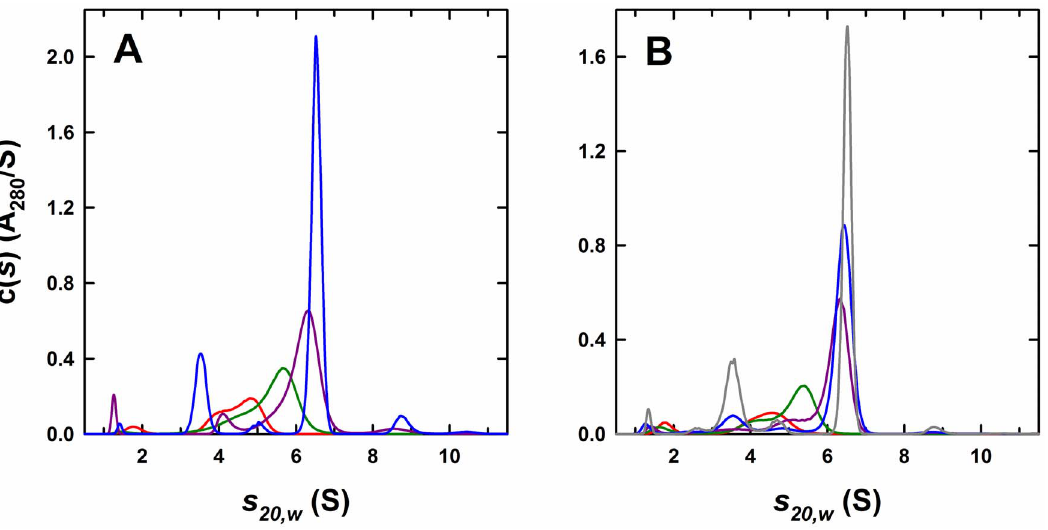
Figure 2. Fab 8066 and 8062 titrations. (A) Sedimentation c(s) distributions for samples containing 2.4 m M of the 3-H and 2.1 (red), 4.3 (green), 6.4 (purple) and 8.5 m M (blue) of added Fab 8066. (B) Sedimentation c(s) distributions for samples containing 2.0 m M of the 3-H and 1.2 (red), 2.4 (green), 4.8 (purple), 6.0 (blue) and 7.2 m M (gray) of added Fab 8062. In both cases the actual amount of CCIZN36 was estimated from the integral contribution of the complex at saturation. Profiles presented are based on sedimentation velocity data collected at 50 krpm and 25.0 u C using the absorbance optical system at 280 nm. Similar profiles were observed using the interference optics.